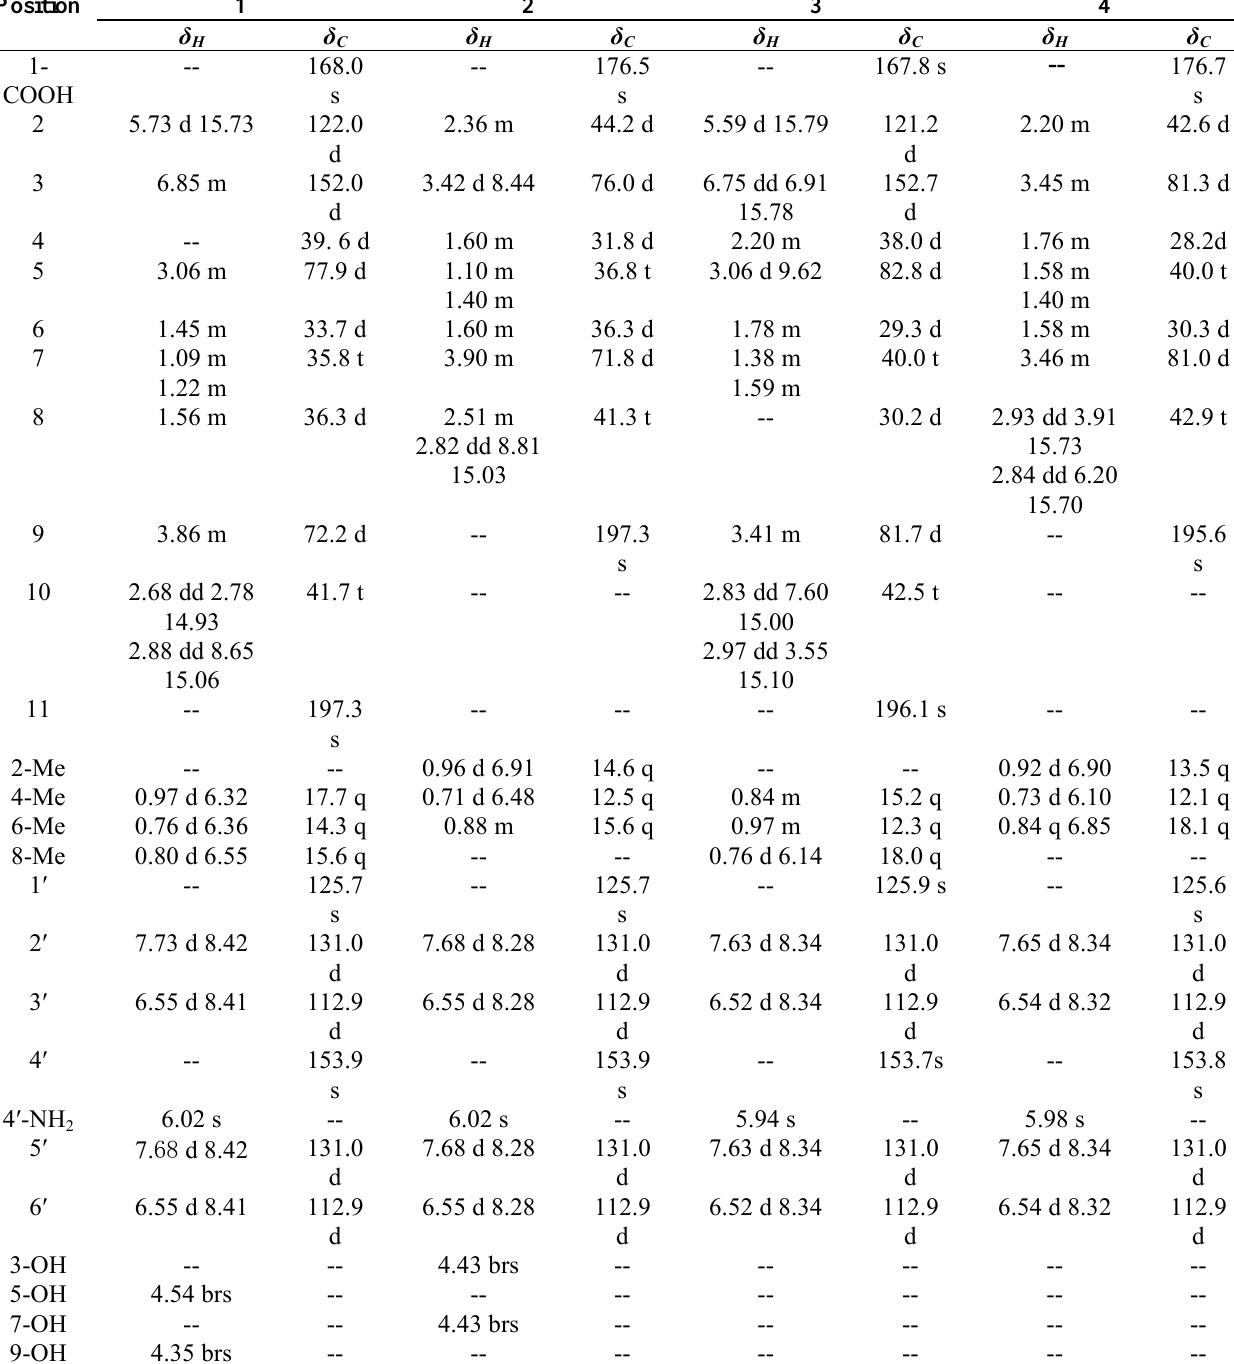
Table 1. 1 H- and 13 C-NMR Data of Compounds 1 , 2 , 3 and 4 .